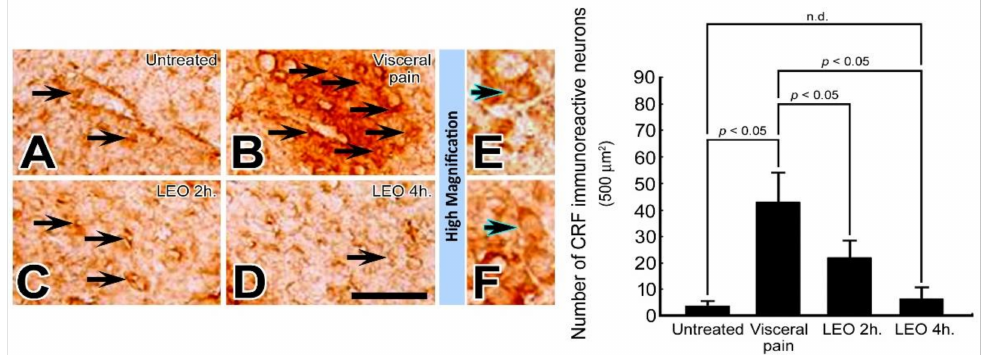
Figure 1. Photomicrographs ( A – F ) and histogram show the CRF immuno-expression in the CeA of the untreated ( A ), visceral pain ( B ), and OS groups receiving LEO for 2 h ( C ) and 4 h ( D ). Note that in the untreated group, nearly no or only a few CRF immuno-reactive neurons were detected in the CeA ( A ). However, following visceral pain, numerous CRF immuno-reactive neurons with strong staining intensity were detected in this nucleus (arrows, B ). Nevertheless, in rats subjected to visceral pain and who received LEO inhalation, the CRF immuno-expression was significantly reduced in which only a small number of CeA neurons were stained with CRF immunoreactivity (arrows, C , D ). High magnification ( E , F ) clearly illustrates the morphological profile of the CRF immuno-reactive neurons (blue arrows) in both untreated ( E ) and OS group (LEO 4 h.) ( F ). Quantitative